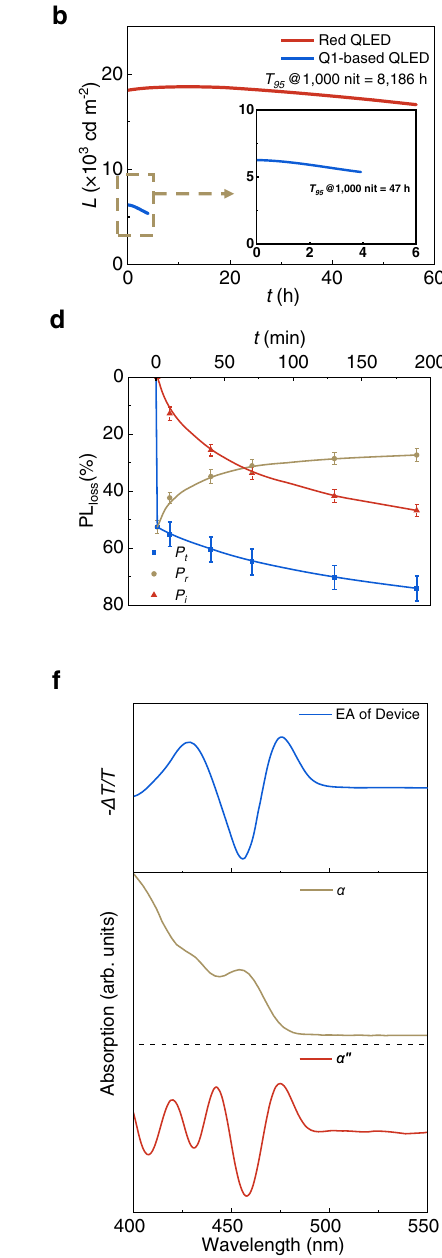
Fig. 1 | Charge-induced degradation in state-of-the-art blue QDs. a The core/ shell/shellstructureofQ1(Zn 0.8 Cd 0.2 Se/Zn 0.7 Cd 0.3 Se 0.4 S 0.6 /ZnS).Theradialelement distribution is obtained by measuring high-resolution TEM and ICP-OES. b Operational lifetime of red and Q1-based devices. The current density is set at 150 and 50mAcm − 2 , respectively. c PL and EL intensity of Q1-based QLEDs simulta- neously monitored as a function of operation time. d Reversible, irreversible, and total PL loss of Q1 measured from corresponding QLEDs as a function of device